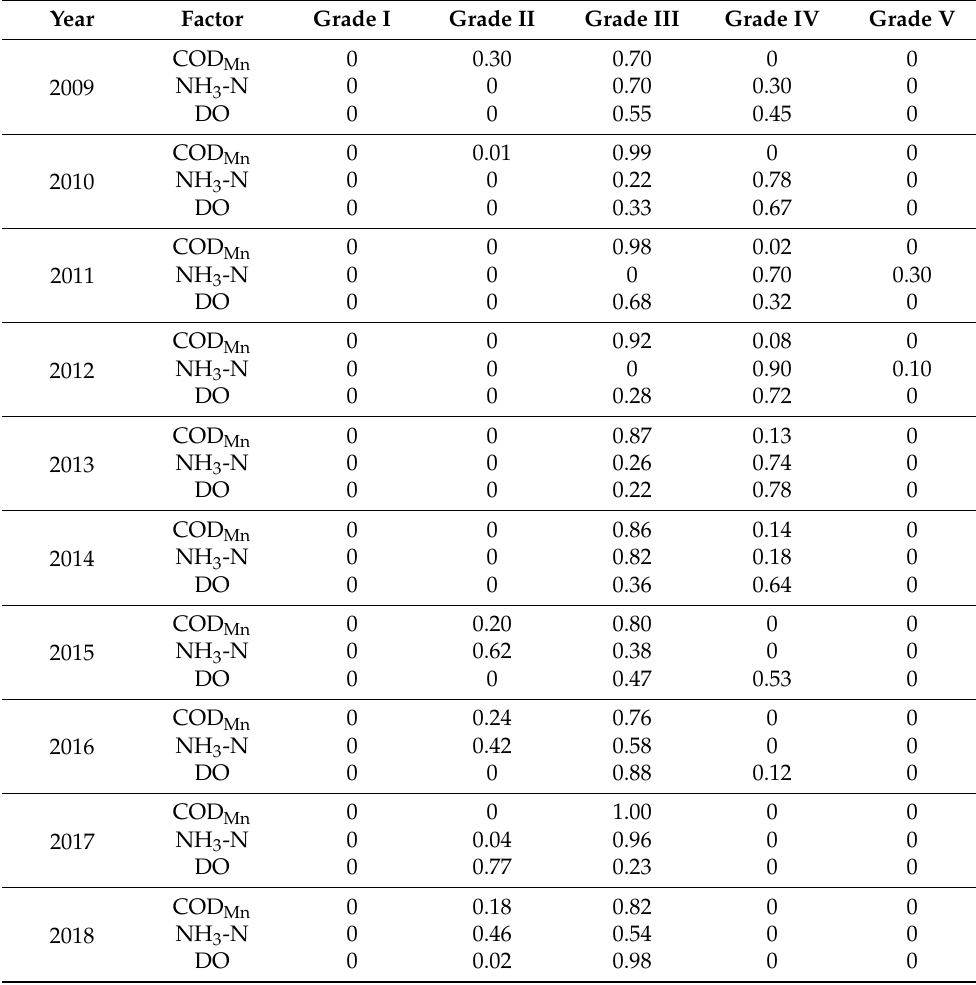
Table A9. Fuzzy matrix of Wangjiangjing Station in Jiaxing, Zhejiang.